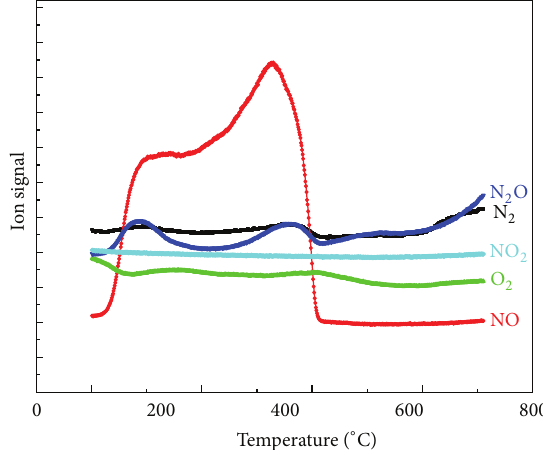
Figure 7: TPD profiles in flowing He after NO adsorption over the In/HZSM-5/In 2 O 3 catalyst.